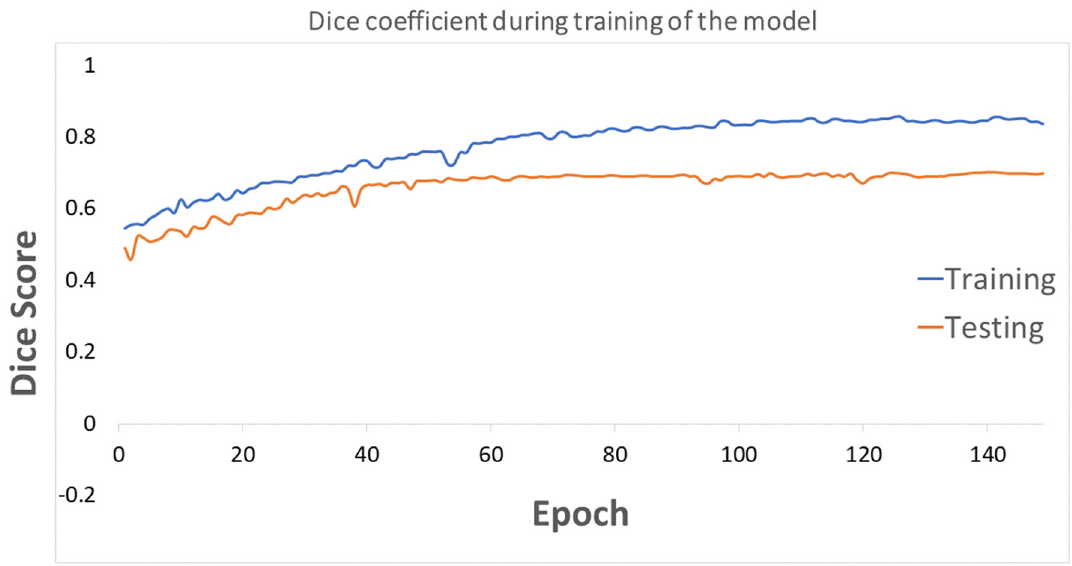
Figure 5. The Dice coefficient loss score is presented for training and testing the model during 150 epochs.